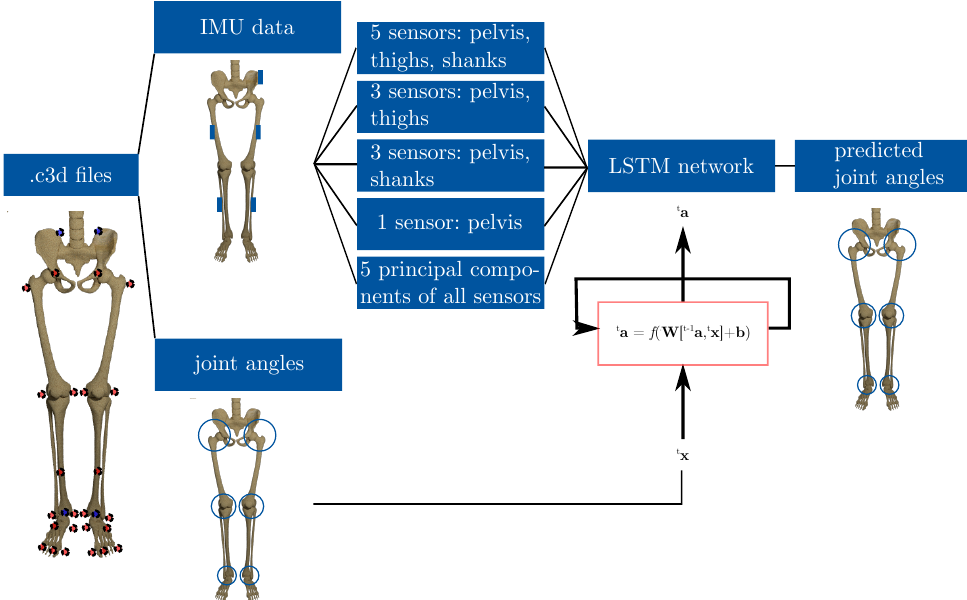
Figure 1. Scheme of the workflow. The marker trajectories of gait trials, saved as .c3d files, were used to calculated inertial sensor data and the joint angles of the lower limbs. The inertial data were divided into five subsets and used as input to train long short-term memory neural networks that were used to predict the joint angles. To adapt its weights and biases for the prediction, the network received the calculated joint angles as target